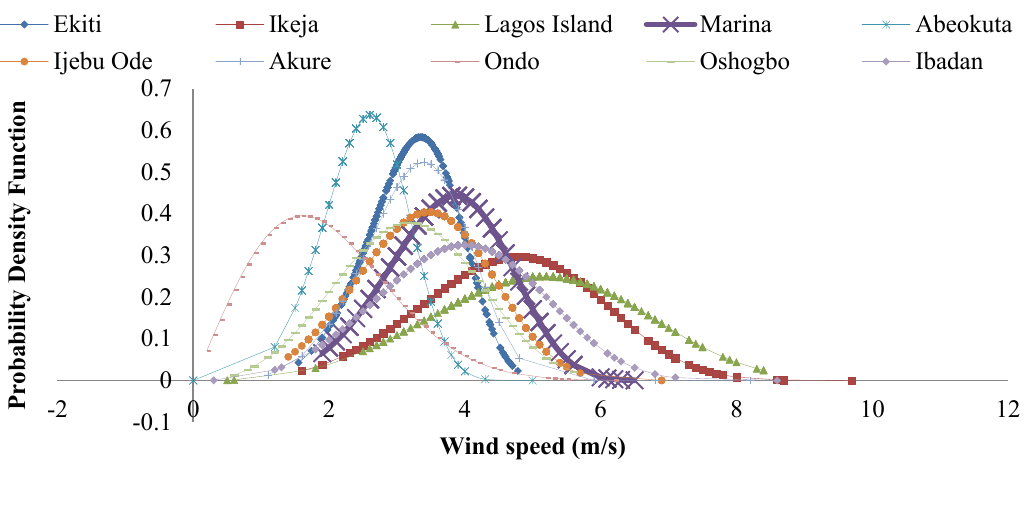
Figure 8. Dry Season’s CDF Plots of all the